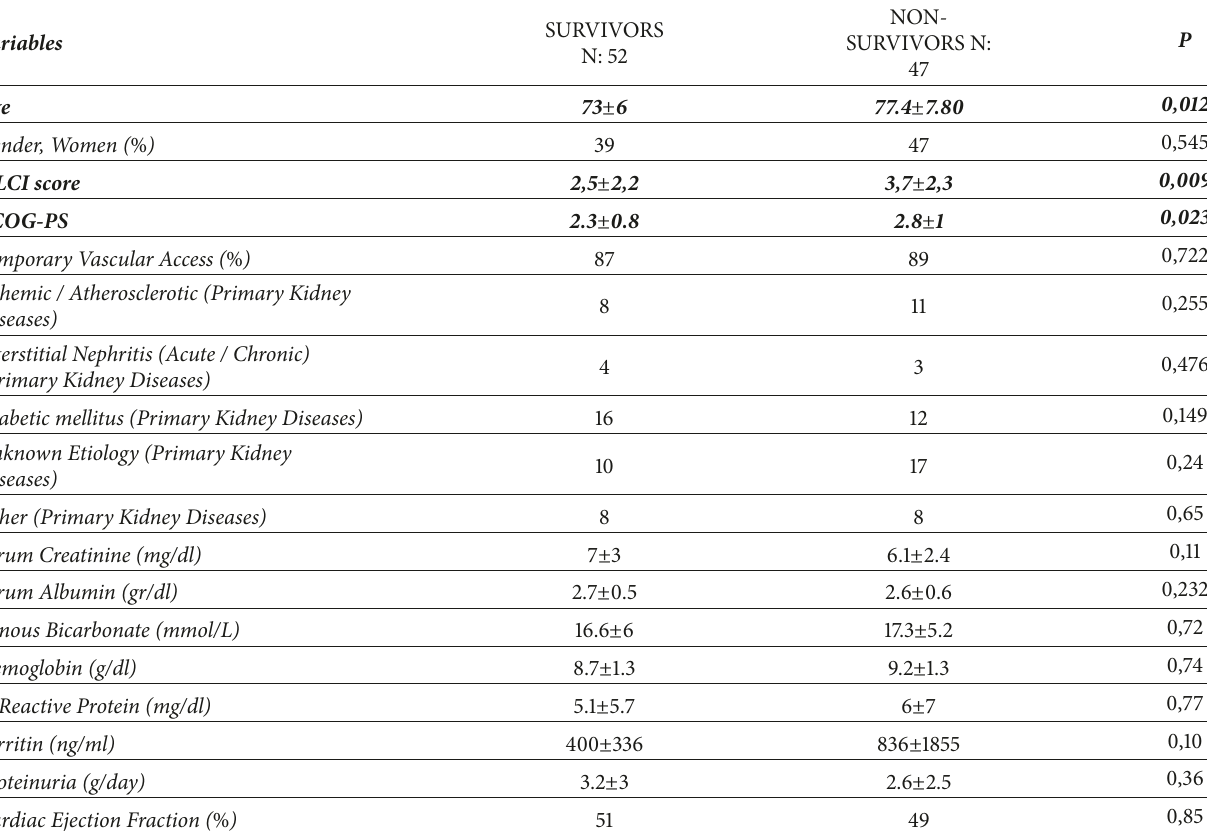
Table 2: Univariate analysis of clinical and metabolic parameters (at the 3rd month after starting hemodialysis). Significance was set at P < 0.05.